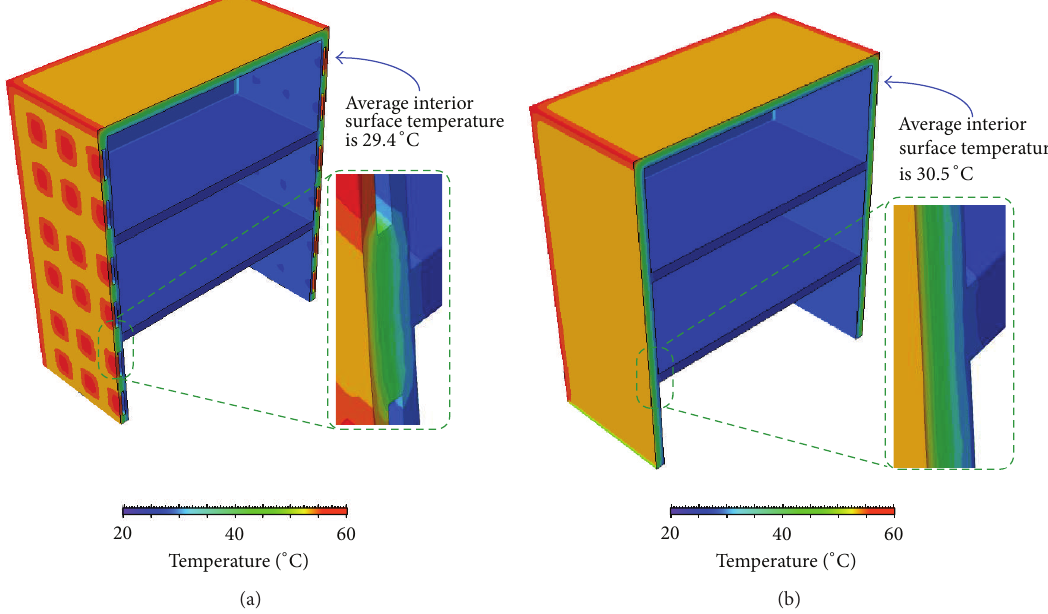
Figure 7: The temperature distribution (after 12-hour solar radiation) of three-story buildings adopting (a) the sandwich concrete/gypsum precast wall panel and (b) the conventional precast concrete wall design. The temperature gradients along the wall in two structures are different. The interior surface temperature of the two buildings is shown and the interior surface temperature is the temperature average measured from all monitoring